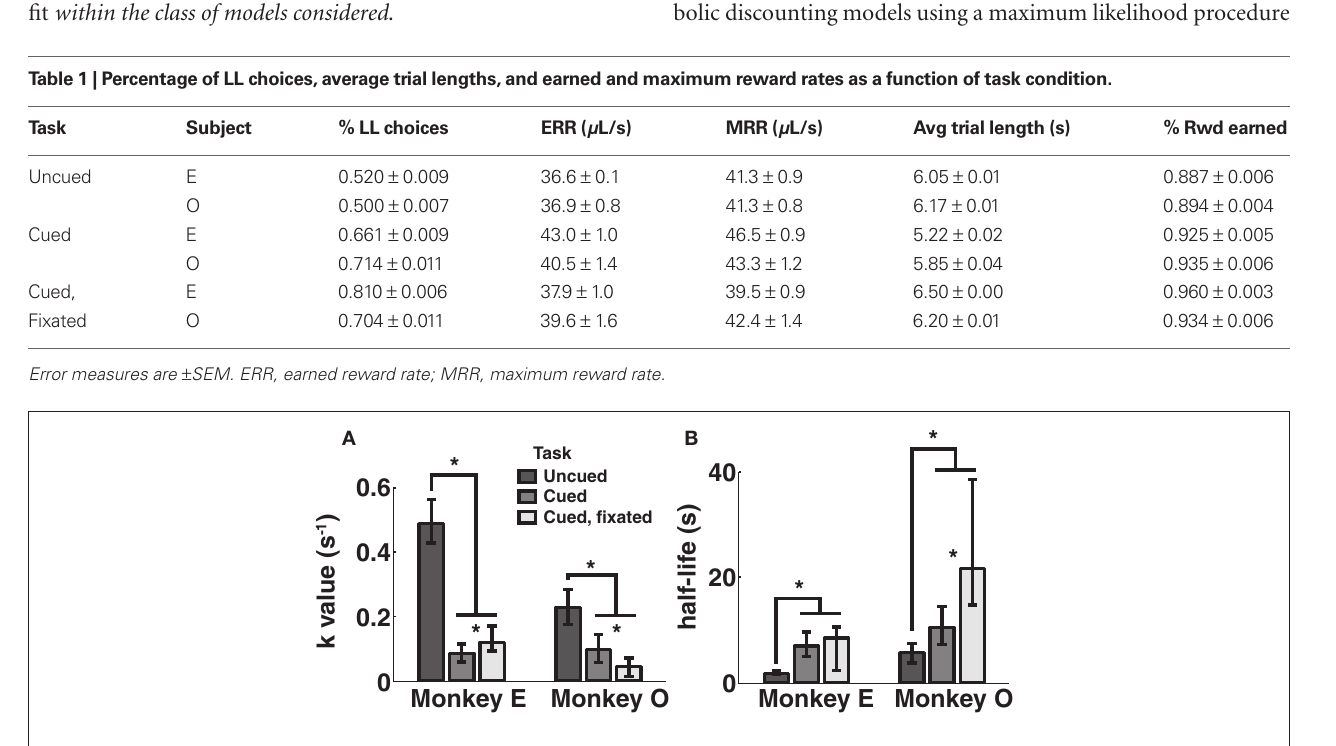
(A) Estimated discount parameter values were significantly lower for both of the two paradigms in which post-reward delays were cued, though not significantly different from one another. (B) Model-averaged effective half-lives were significantly increased in both explicit cuing